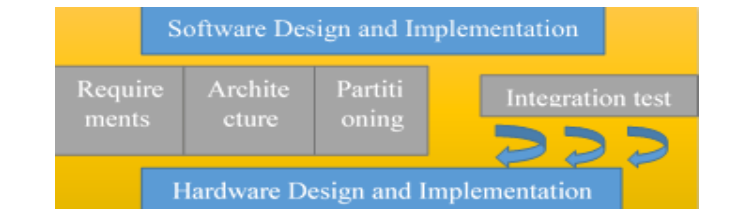
Fig. 4. Hardware and Software integration